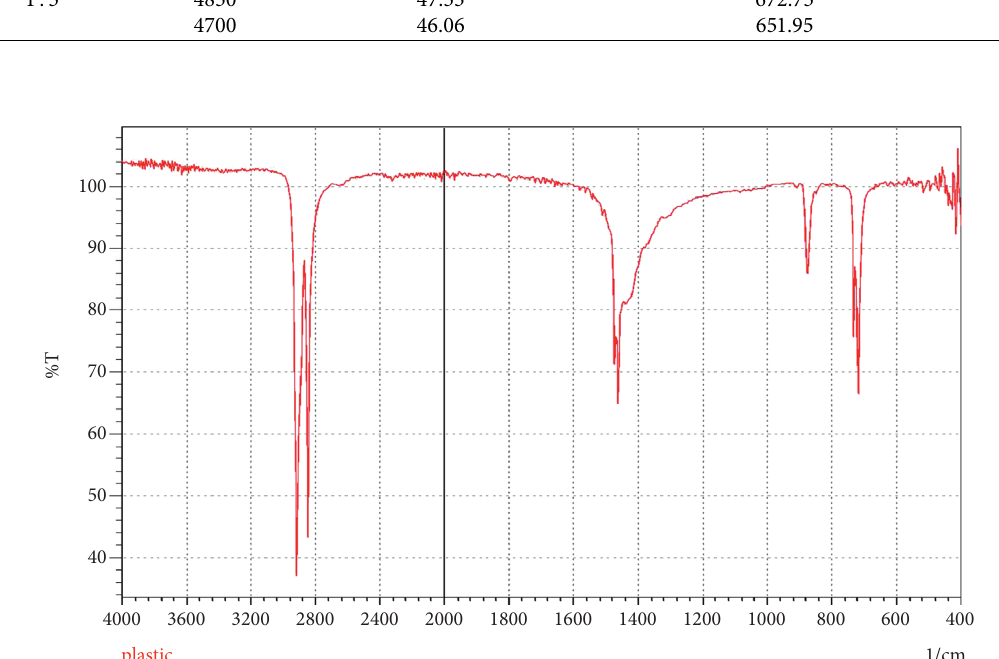
Figure 12: FTIR spectrum of Low-Density Polyethylene (Sample